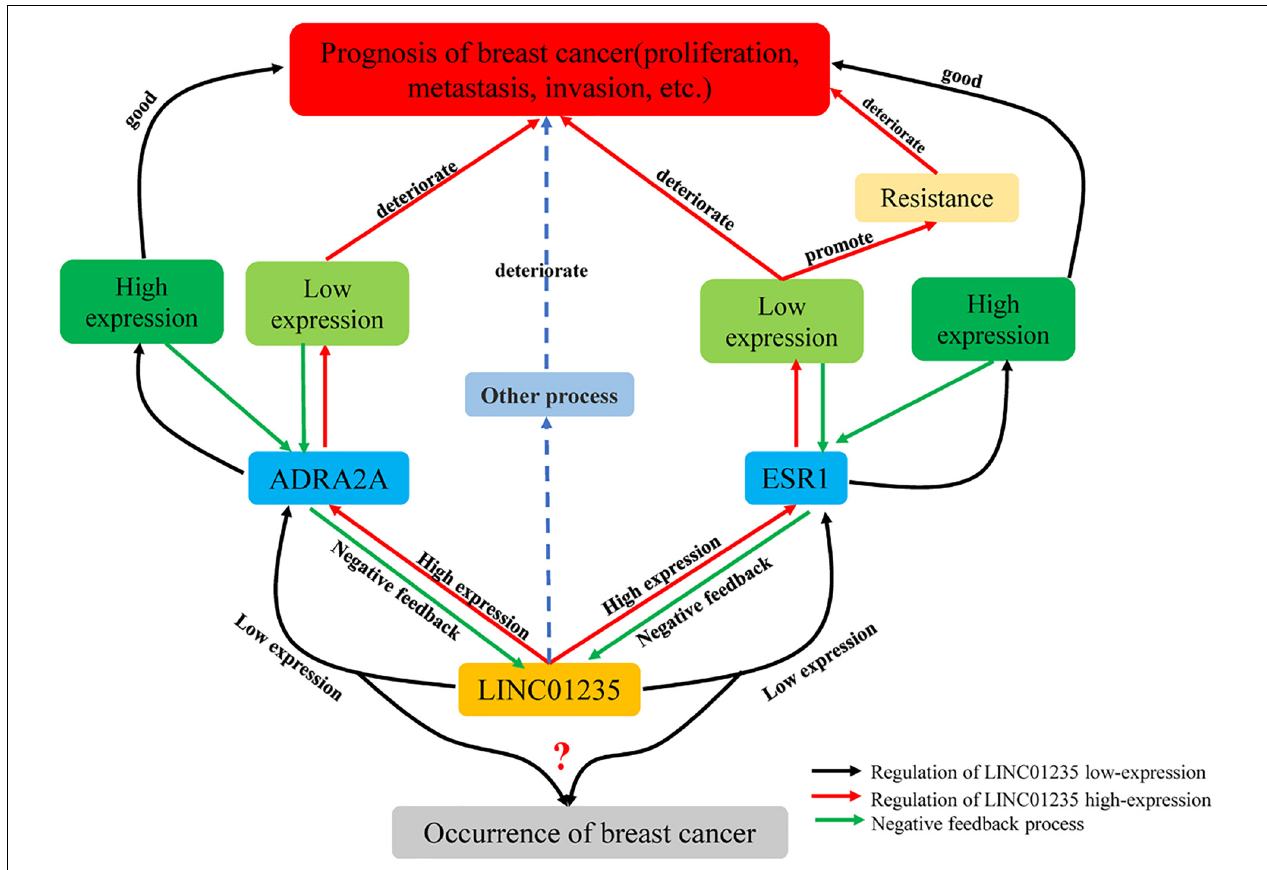
FIGURE 8 | Regulation of LINC01235-ADRA2A and LINC01235-ESR1 in breast